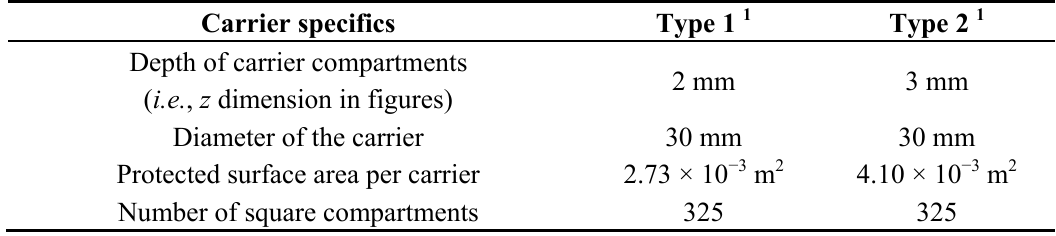
Table S1. Characteristics of biofilm carriers. *